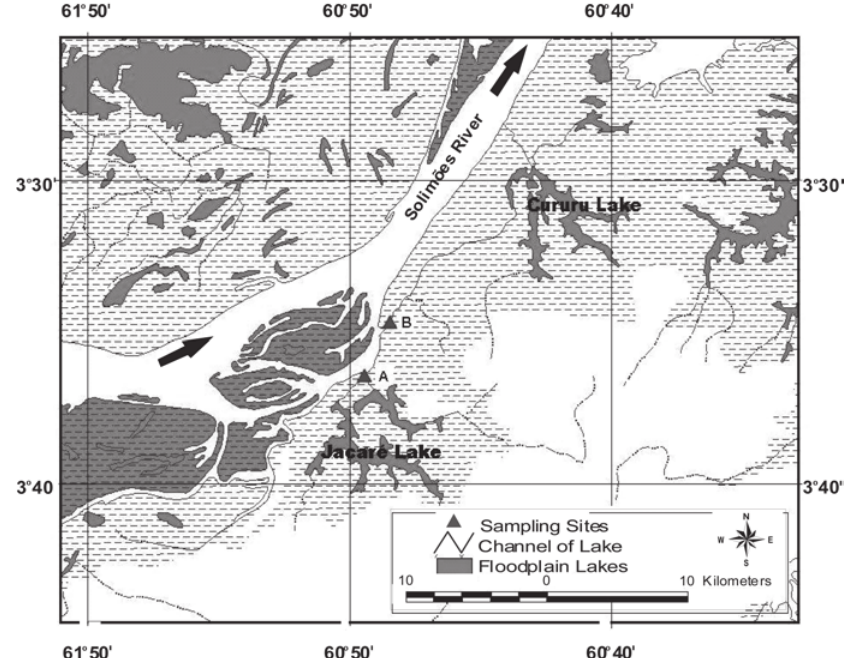
Fig. 1. Study area indicating the two sampling sites: (A) Jacaré lake canal and (B) Cururu lake canal. They are located in the municipality Manacapuru-Amazon-Brazil (PIATAM Project/ArcView